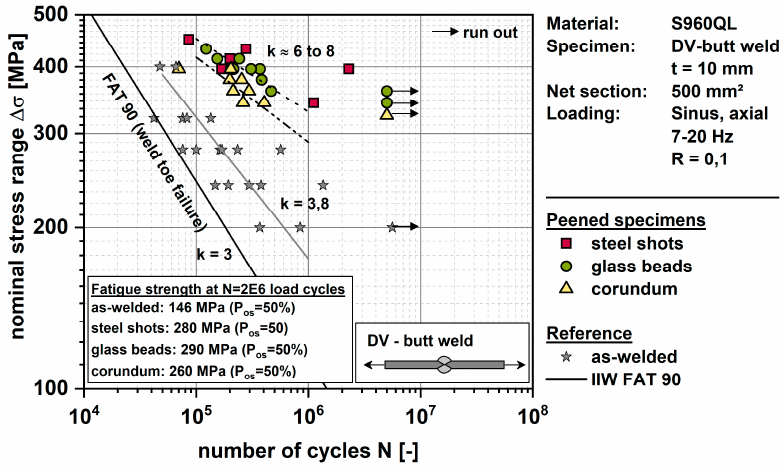
Figure 8. Fatigue test data of clean blasted DV-butt welds made from S960QL. Shown here are test series 4–9.